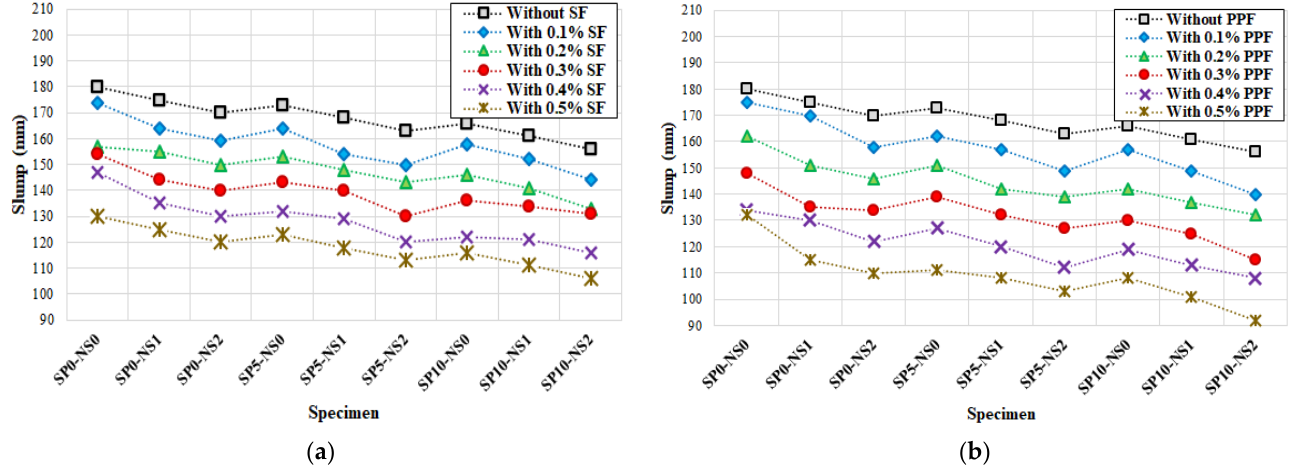
Figure 5. Effect of fibre on the slump of HSC containing NS and SP ( a ) SF and ( b ) PPF.